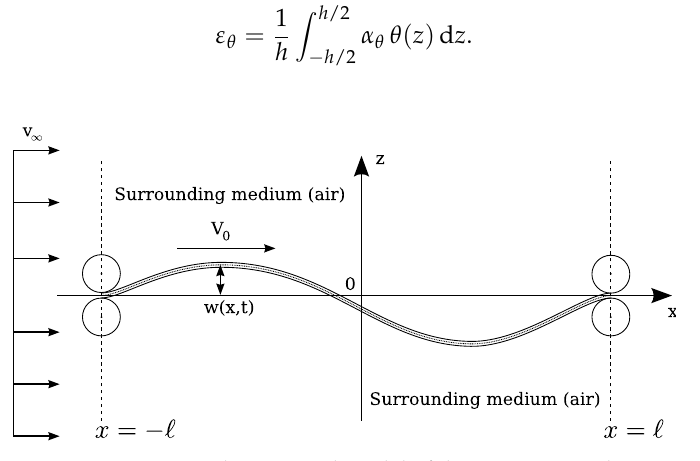
Figure 1. One-dimensional model of the moving